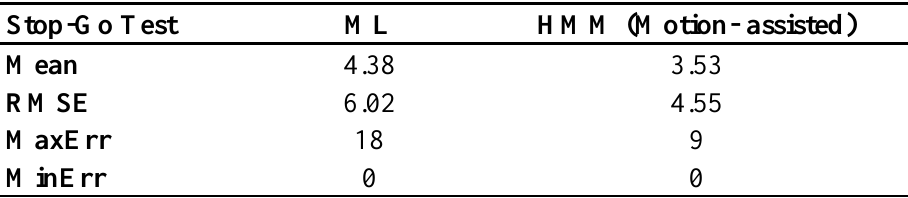
Table 6. Stop-Go Test (Unit: m).